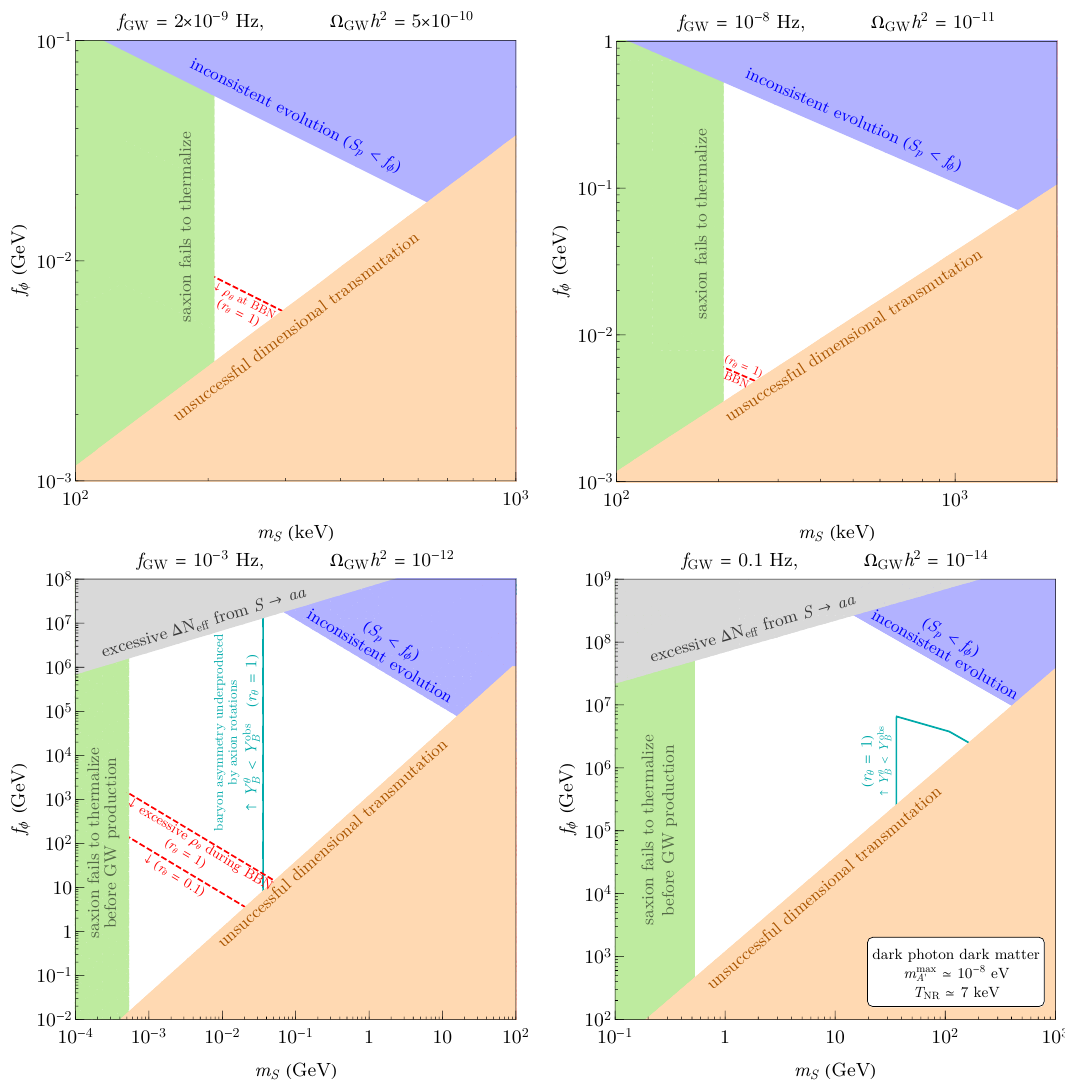
Figure 2 . The white regions may lead to GW signals as motivated by NANOGrav (top left), SKA (top right), LISA (bottom left), and DECIGO and BBO (bottom right). We fix the vector-like lepton mass m L = 1 TeV and r p = 20 with g ∗ ( T p ) = 10 . 75 (200) for the top (bottom) panels. The exclusion regions follow from eq. (5.6) for orange, below eq. (5.9) for blue, above (around) eq. (5.10) for red (gray), and eqs. (5.13) and (5.15) for green. To the right/below the cyan lines, the axion rotation can also explain the observed baryon asymmetry via eq. (5.23). In the bottom right panel, the dark photons may explain dark matter. In other panels, they can be sufficiently cold to be dark matter if a cascade to IR occurs via scattering, as considered in section 4.2; otherwise, they are taken light, contributing to ∆ N eff by eq.